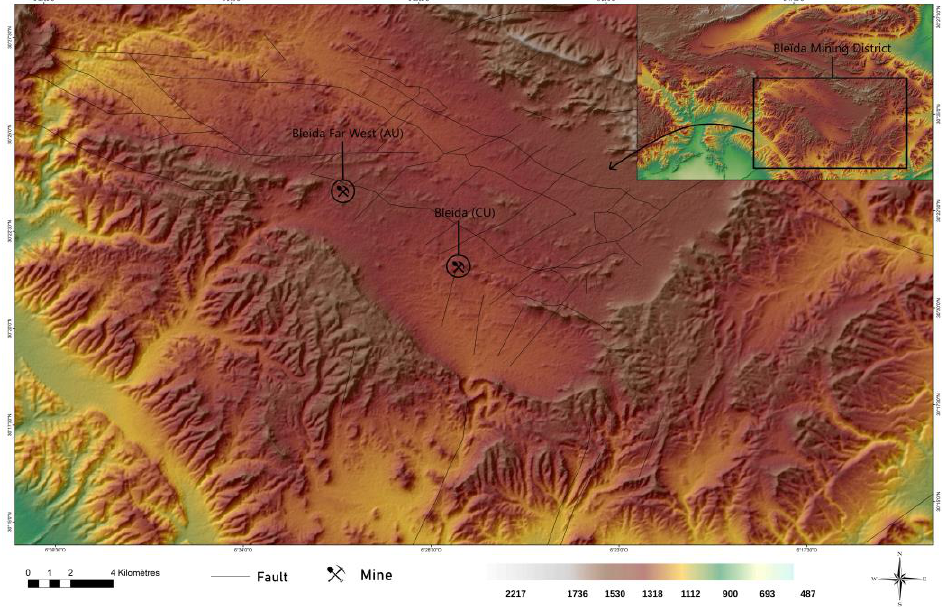
Figure 7. Location of the Bleïda mining district on the DEM of the Bou Azzer–El Graara inlier. Bleïda copper mineralization is hosted in platform deposits of the Lower Neoprote- rozoic Tachdamt–Bleïda Group, which is part of the Taghdout–Lkest Group defined on the northern margin of the West African Craton [5,49]. This series takes the form of an elongated strip WNW-ESE over about 11 km with an average width of 2 km. The age of this platforms series has been established at 788 ± 9 Ma [50]. It constitutes the oldest unit of the inlier; the Bleïda district is located at the eastern end of the Bleïda granodiorite,